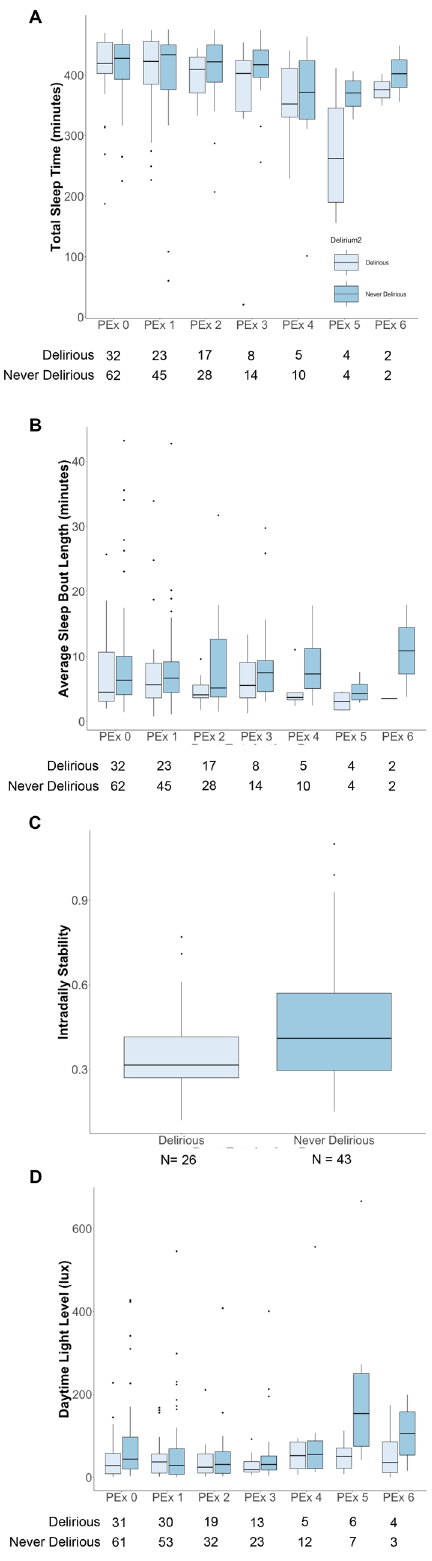
Figure 3. Actigraphy metrics between drug groups. ( A ) Total sleep time. Boxplots of total sleep time over the nighttime period between groups based on post-extubation day. ( B ) Sleep Bout Length. Boxplots of average sleep bout length over the nighttime period between groups based on post-extubation day. ( C ) Interdaily Stability. Boxplots of overall interdaily stability between groups. ( D ) Daytime light exposure. Boxplots of lux levels over the daytime